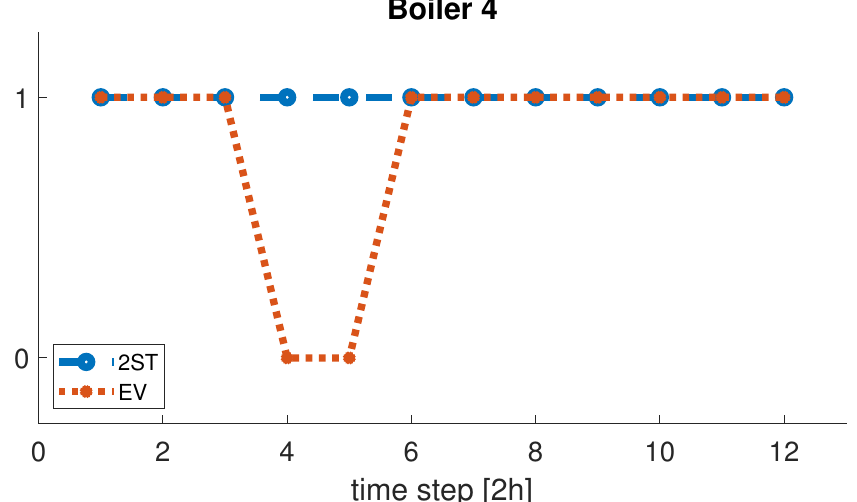
Figure 11. Comparison of the operation modes of Boiler 4 between 2ST and EV